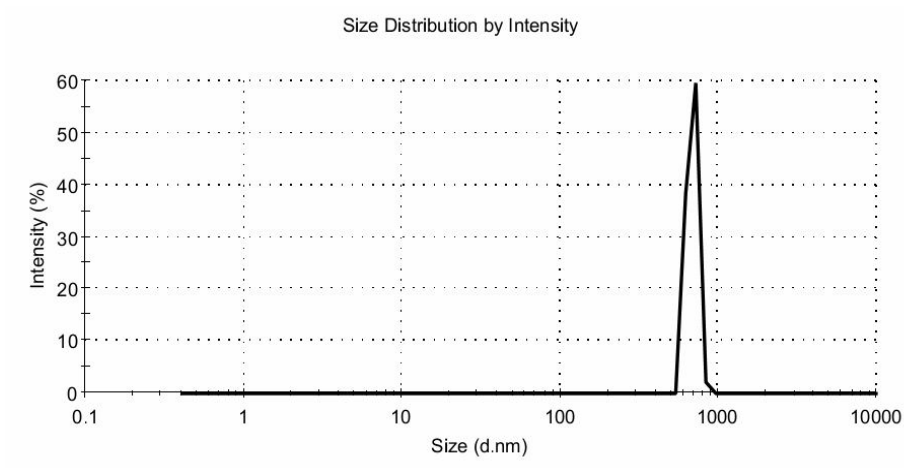
Fig. 4. Size distribution manifested by DLS through Zetasizer analysis where arc fabricated silver nanopowder (AgNP) show an intrinsically wider size distribution in water.